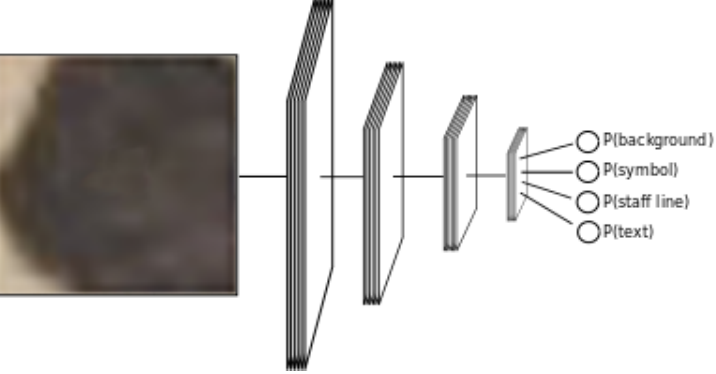
Figure 4. Graphical scheme of the prediction process for a given pixel (represented by its extracted